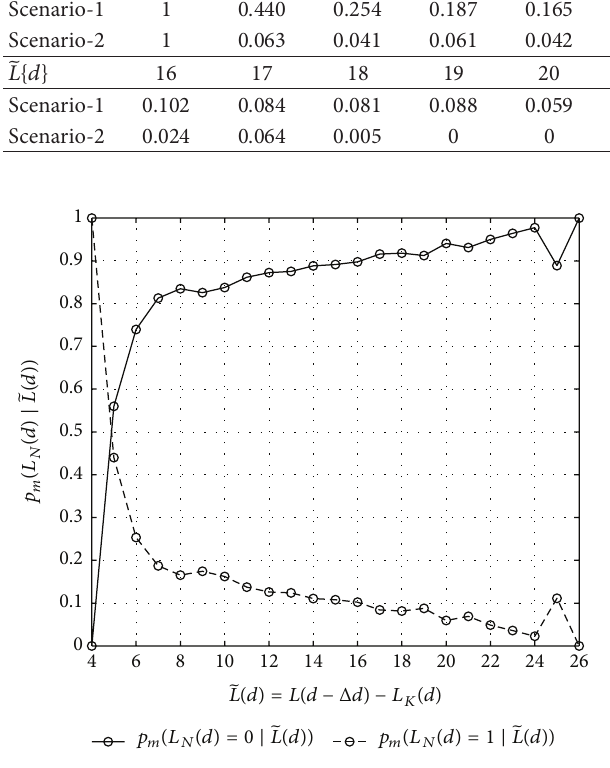
Figure 12: Conditional PMF 𝑝 𝑚 (𝐿 𝑁 (𝑑) | Scenario-1.